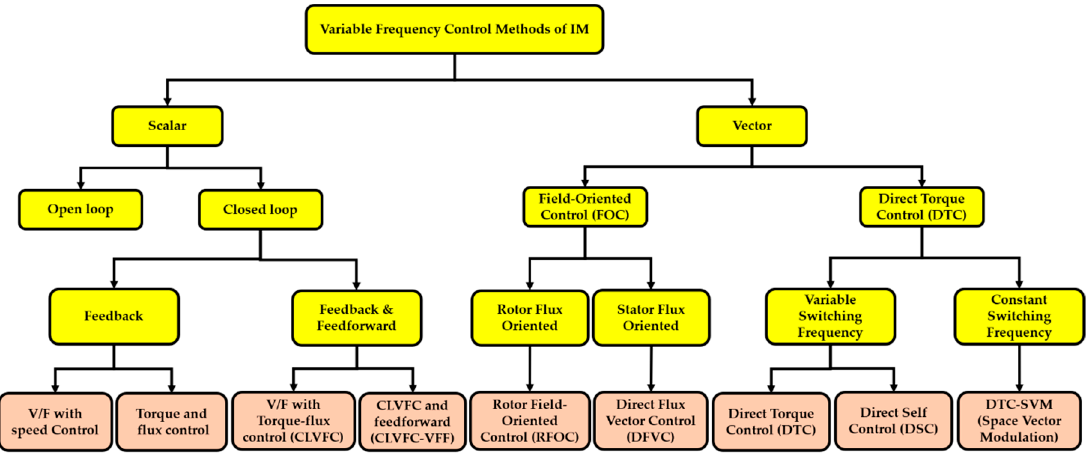
Figure 4. Control methods for IMs.